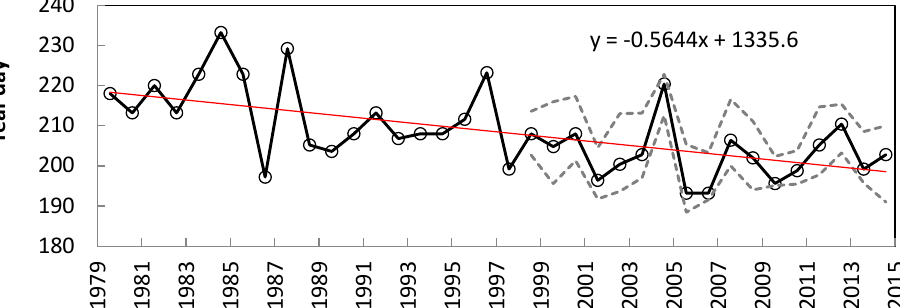
Figure 10. Temporal change in the timing of cyanobacteria accumulations for the Baltic Sea. The circles connected with a solid line show the “center of timing” (modified after Kahru and Elmgren, 2014, by adding 2014 data). The red line is the estimated linear regression for the Baltic (area in Fig. 1a). The gray dotted lines show the mean start and end of the accumulations for the whole Baltic Sea. For reference, 1 July is year day 182 (183 in leap years), year day 200 is July 19 (in leap years, July